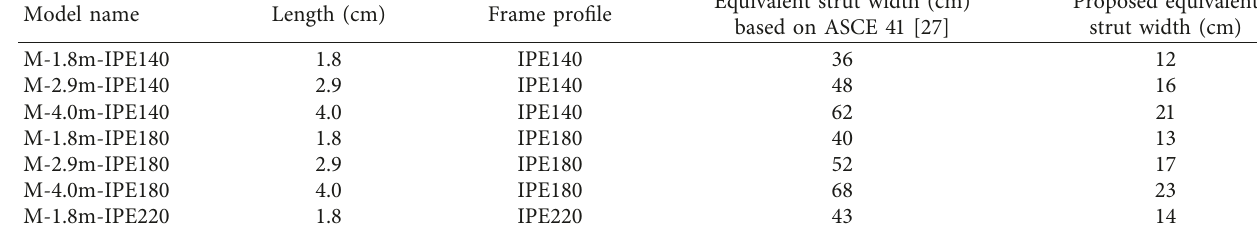
Table 4: Characteristics of the models with reinforced gypsum for determination of the equivalent strut width.